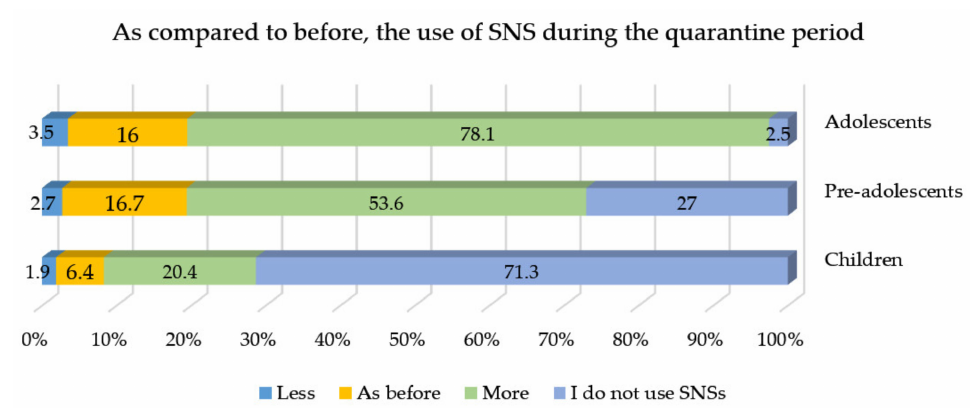
Figure 2. Frequency (%) of social network site (SNS) use during the quarantine period compared to before quarantine ( N = 1047).